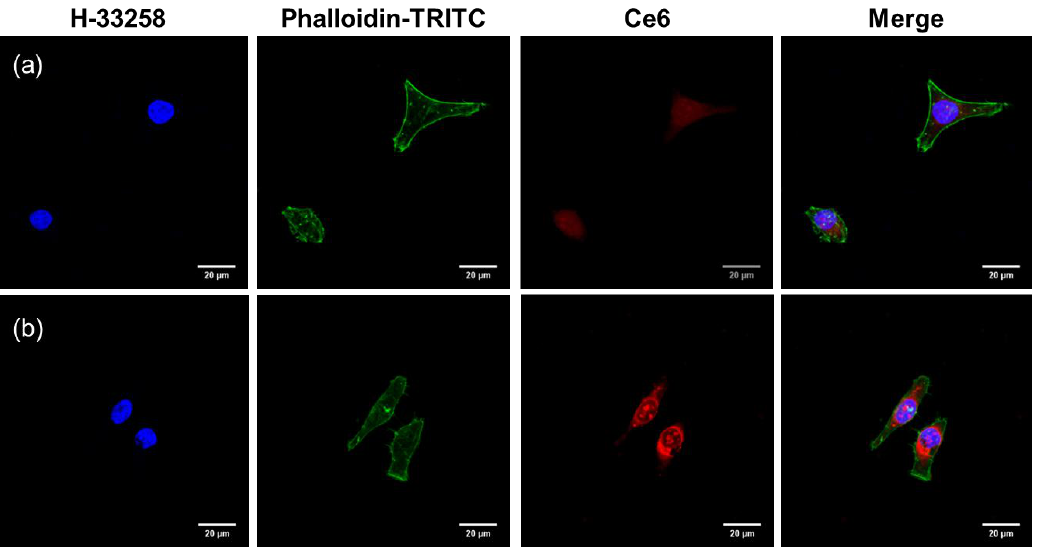
Figure 6. Confocal laser scanning microscopy image of the intracellular distribution of ( a ) free Ce6 and ( b ) DC in HeLa cells after incubation for 2 h in the dark.